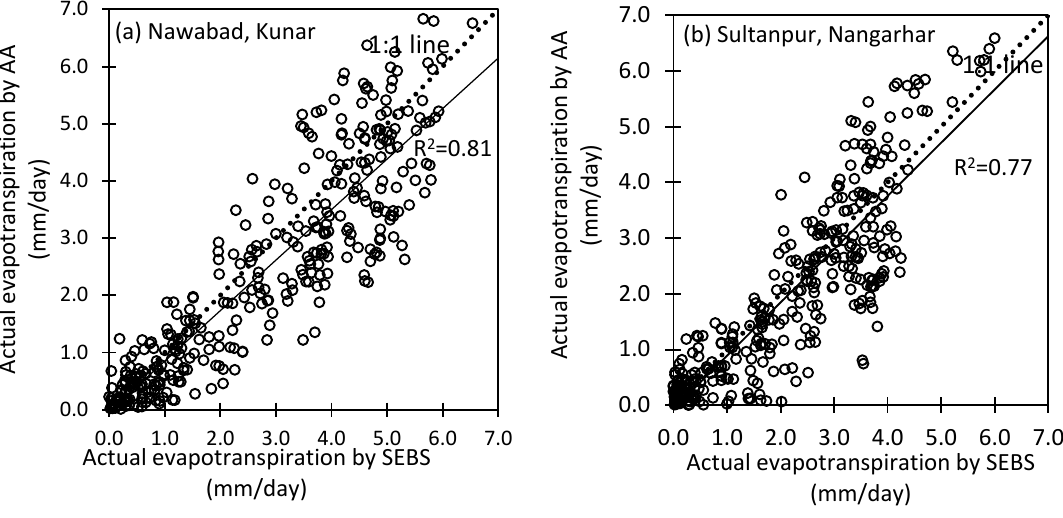
Figure 4. Comparison of the daily actual evapotranspiration estimated through SEBS algorithm and AA model (1 January 2013–31 December 2013) at ( a ) Nawabad (Kunar) and ( b ) Sultanpur (Nangarhar) stations of the Kabul River Basin.